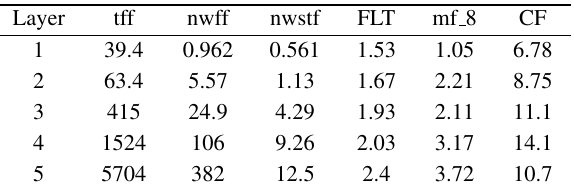
Table 4 Differences of online interaction indicators among five types of guanxi layer.